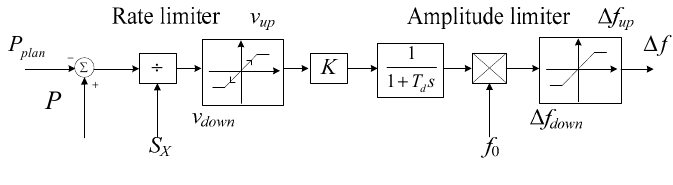
Figure 5. Virtual frequency (VF) control diagram.